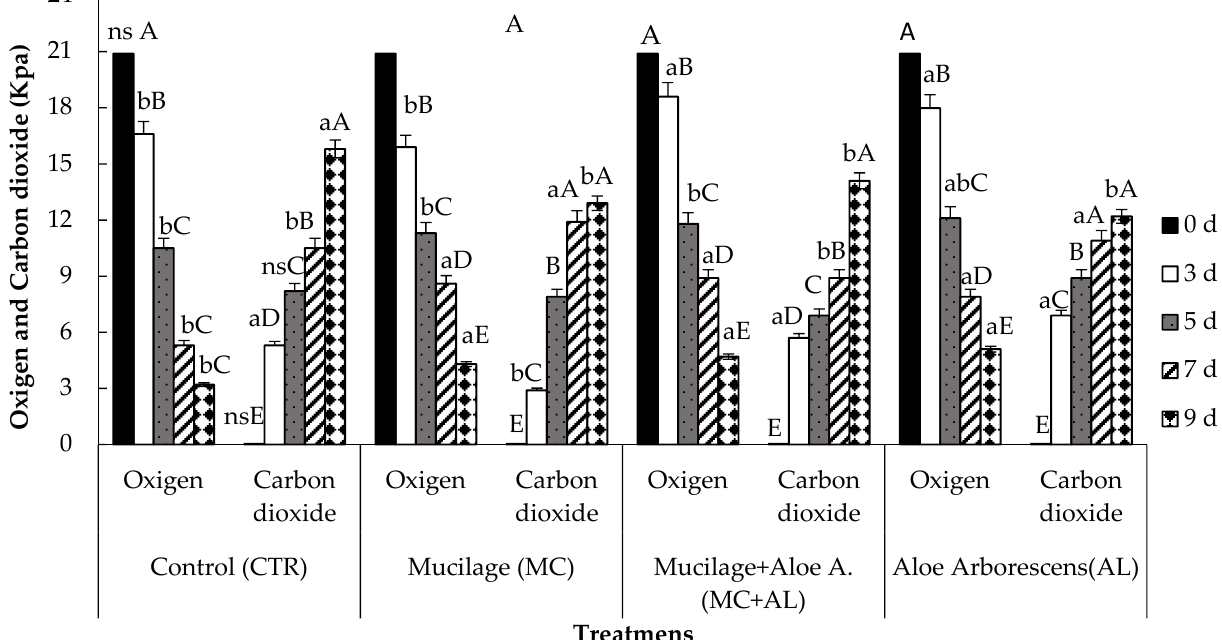
Figure 6. Oxygen and Carbon dioxide content (kPa) inside packages with fruit slices of Actinidia de- liciosa (Liang, Ferguson) coated with O. ficus-indica (OFI) mucilage (MC), or mucilage + A. arborescens (MC+AL), or A. arborescens (AL) not treated (CTR), just after being coated (0) and at 3, 5, 7, 9 days of storage at 5 ◦ C Different lowercase letters indicate significant differences between treatments at each sampling date. Different capital letters indicate significant differences between sampling date for the same treatment and parameter (Oxigen, carbon dioxide). Tukeys’ significant test was applied at p ≤ 0.05. Data are means ± S.E. (n = 3).